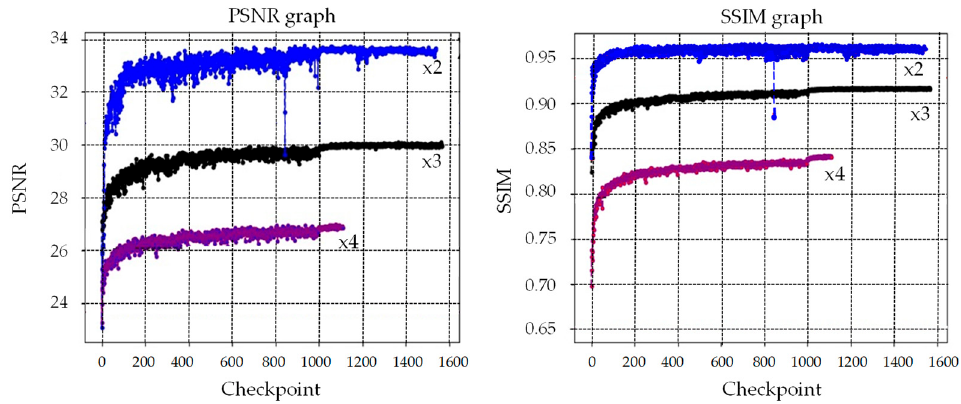
Figure 2. Trends of the average PSNR and SSIM results, according to the checkpoint.